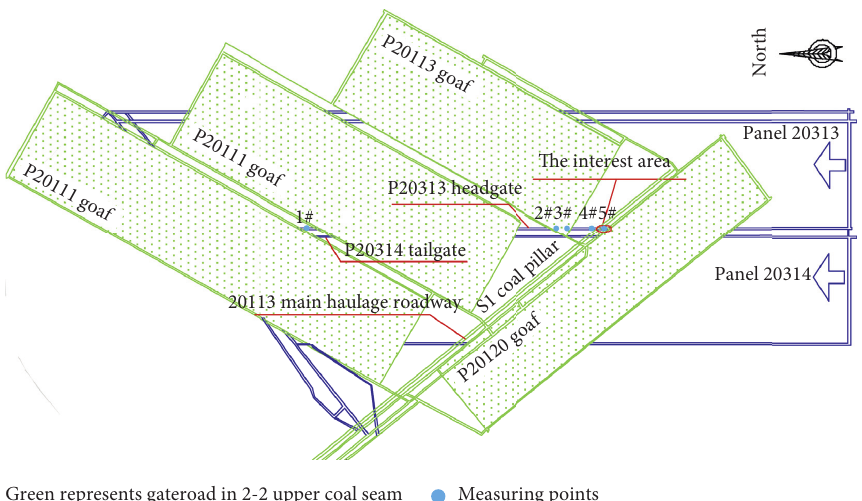
Figure 3: Layouts of the 2-2 upper and 2-2 middle coal seams.